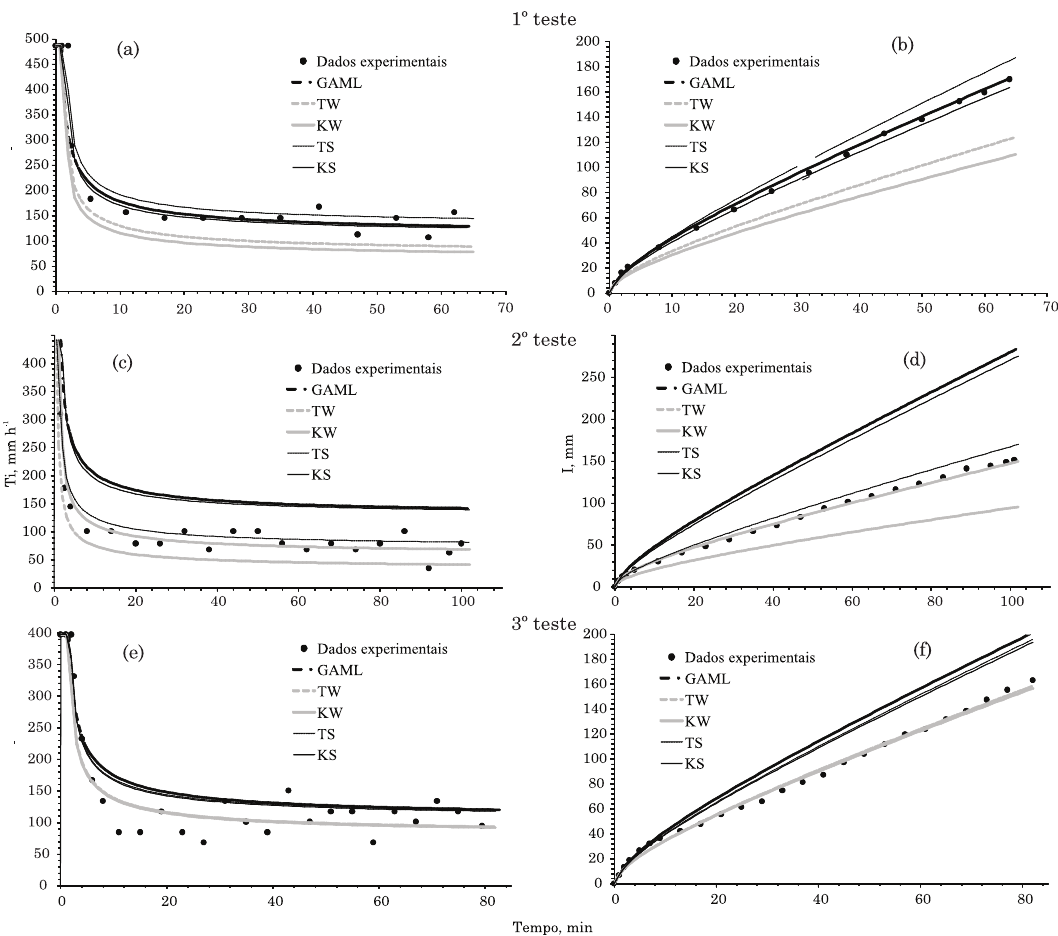
Figura 4. Taxas de infiltração (a) e lâminas infiltradas (b) medidas e estimadas no 1º teste; (c) e (d), no 2º teste; (e) e (f), 3º teste. Quadro 4. Coeficientes estatísticos calculados para as estimativas da lâmina infiltrada e da taxa de infiltração feitas pelo GAML original e pelo GAML-c nos três testes